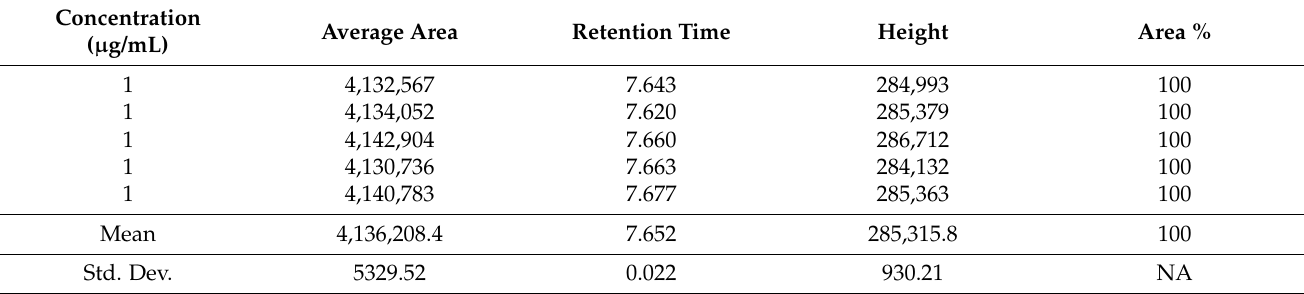
Table 3. Average retention area, retention time and peak height of stock